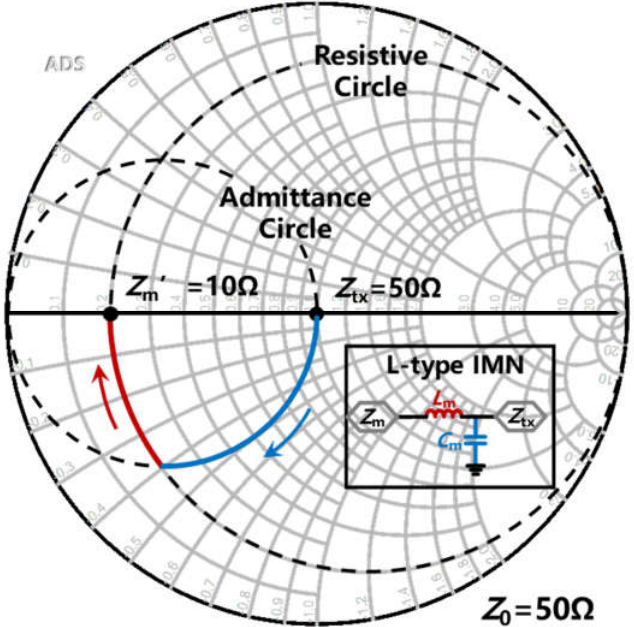
Figure 5. Impedance transformation with L-type IMN.